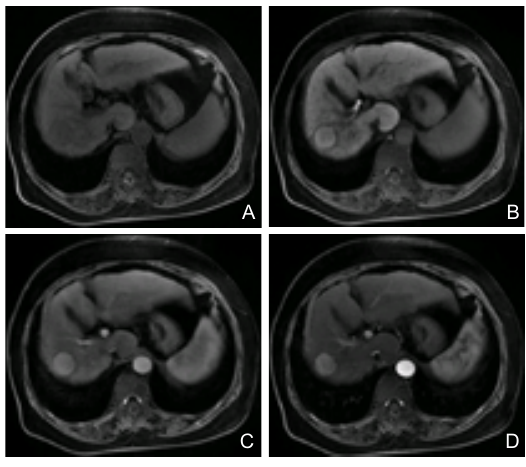
Figure 3 Abdomen contrast enhanced MRI. Post-contrast (A) T1- weighted image showing a isointense nodule (white arrow) in the right posterior lobe of liver and high enhancement (white arrow) in the arterial phase (B) and appears hyperintense (white arrow) on the delayed phases (C). In the hepatocyte phase (D), the nodule shows low uptake after intravenous Gd-EOB-DTPA injection. Features are not typical for HCC.